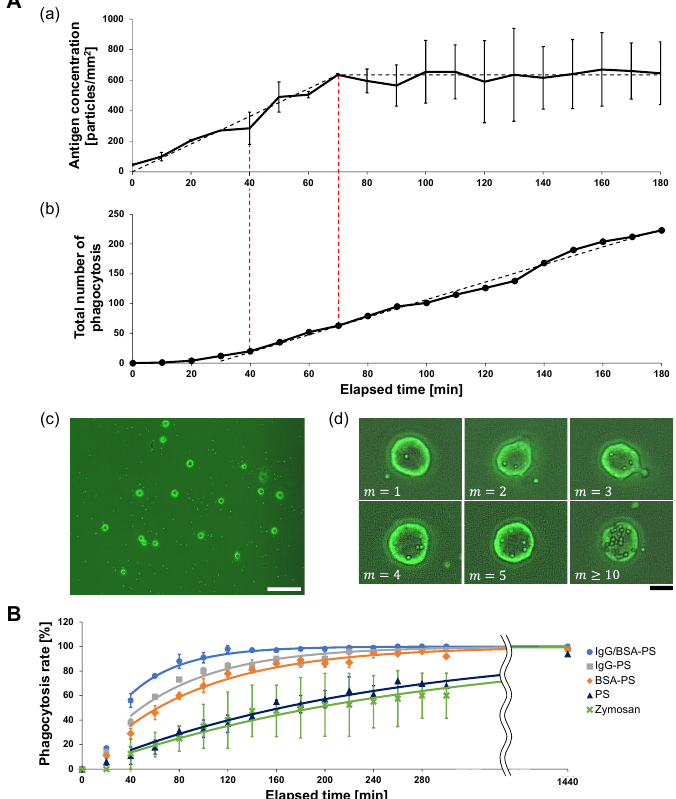
Figure 2. Time-course change in antigen concentration and total number of phagocytozed macrophages in the on-chip free-flow method. ( A ). Time-course change in antigen bead concentra- tion and the total number of antigen beads phagocytozed by macrophages. ( a ) Time-course change in flowing antigen concentration at the observation area. The concentration of flowing antigens became stable 70 min after the flow started. The black dashed line is the model line when the antigen concentration is assumed to increase at a constant rate during the initial 70 min toward the bead concentration after 70 min (635particles/mm 2 ) and then remain constant. ( b ) Total number increase of antigens phagocytozed by 33 macrophages. The black dashed line is the fitting line using the least-squares method for the plot after 40 min when the rate of increase in the number of phago- cytozed beads became constant. The slope of the dashed line is 1.5/min. ( c ) Micrograph of the entire observation area at 70 min when the antigen concentration became constant. Bar: 100µm. ( d ) Micrograph of macrophages phagocytosing antigen beads. The m in the lower-left of each picture represents the engulfed antigen number. Bar: 10µm. ( B ). Sample surface decoration dependence of phagocytic efficiency. The phagocytic efficiency of five types of antigens was compared: IgG/BSA-PS (light blue dots, error bars and line, n = 100 cells), IgG-PS (gray, n = 100), BSA-PS (orange, n = 100), PS (dark blue, n = 100), and Zymosan (green, n = 40). The dots and error bars represent the mean and standard deviation of the experimental values, respectively, and the lines are the fitting curves according to Equation (6). The phagocytosis ratio at each time represents the percentage of macrophages that phagocytozed at least one antigen relative to the total number of macrophages. Since Zymosan is a digestible biological sample, data for 1440 min could not be obtained because it is not possible to confirm by direct observation whether or not the macrophages after an extended period are cells after